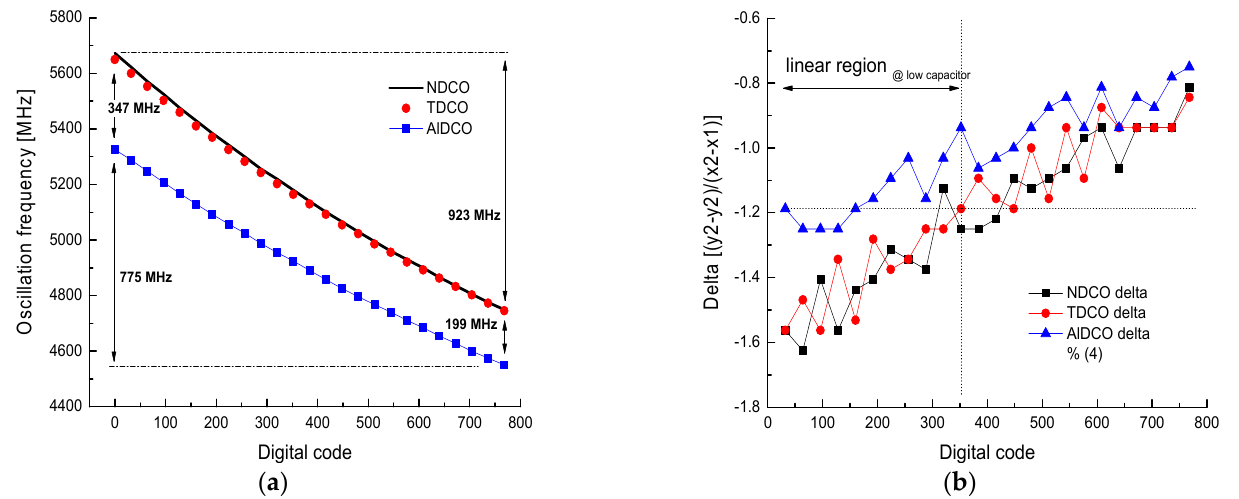
Figure 8. Measurement of three test DCOs: ( a ) oscillation frequencies and ( b ) linear frequency control.